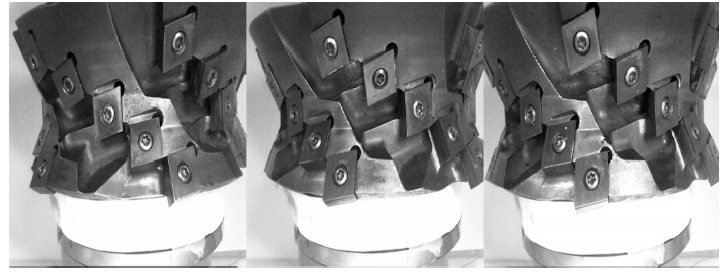
Figure 2. Acquired sample images from cutting edge dataset.